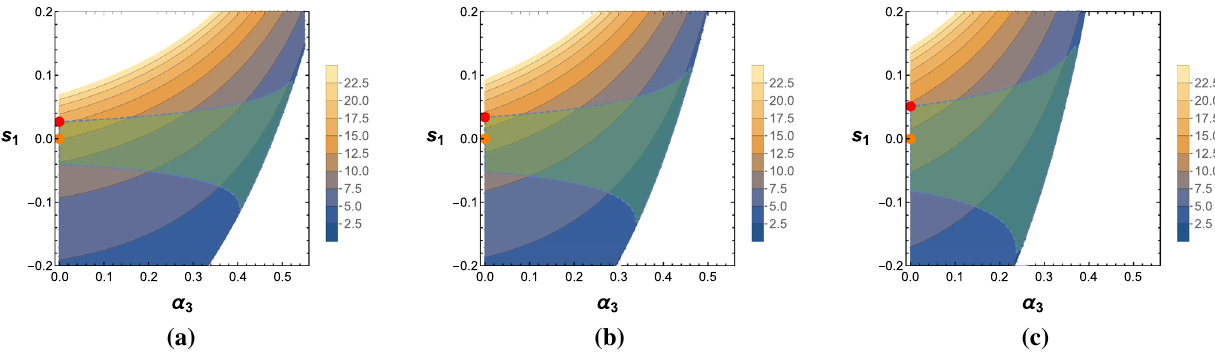
Fig. 6 The contour maps of E 3 in terms of α 3 and s 1 . The timelike condition for particle 3 is satisfied in the light-green shaded region with different values of n . the maximum value of E 3 for the spin- ning case is labeled by the red point, and the non-spinning case is labeled by the orange point ( α 3 = 0 , s 1 = 0). a When n = 0, for the spinning case, E 3 max ≈ 15 . 6350 with s 1 ≈ 0 . 02670; for the non-